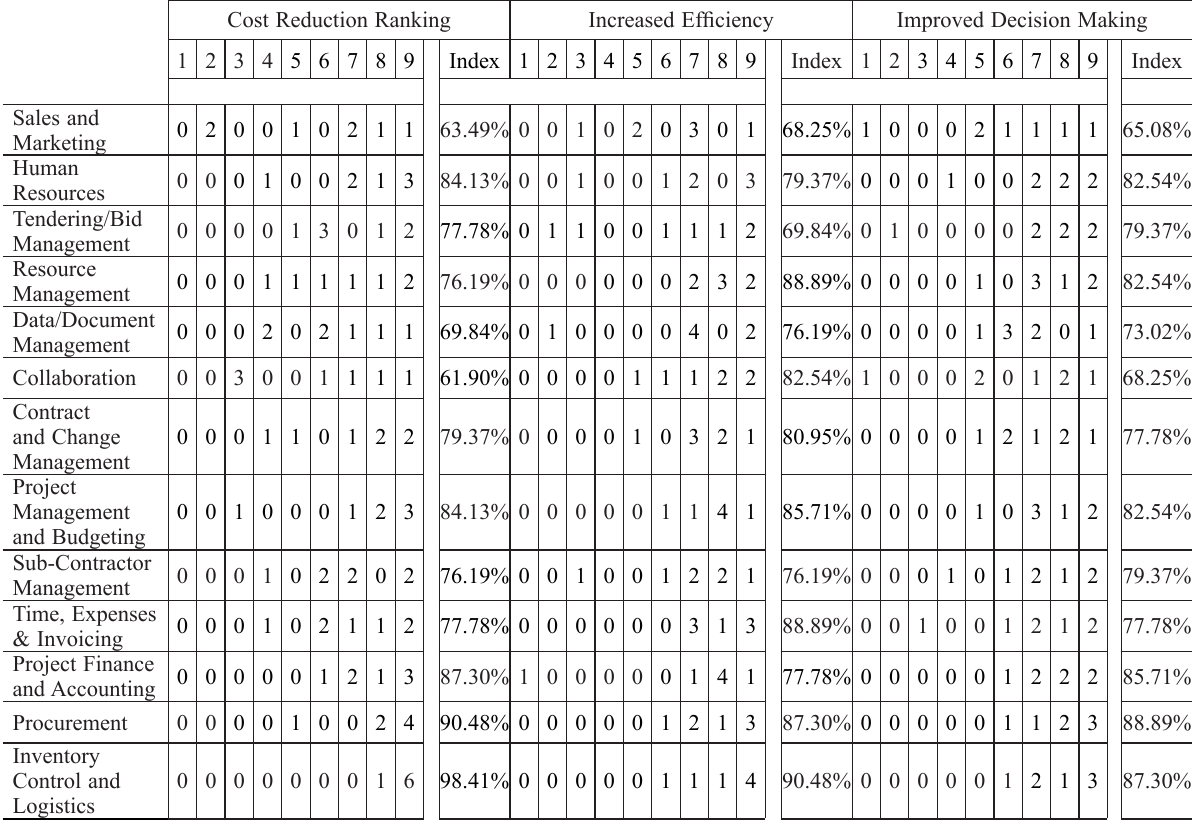
Table 3. Modules’ index for benefits cost reduction, increased efficiency and improved decision making